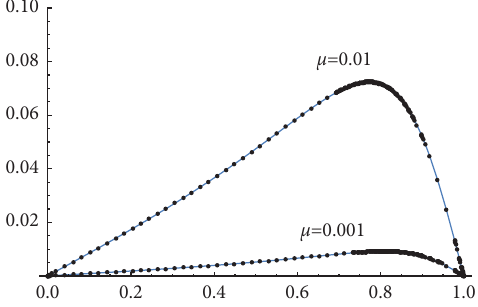
Figure 8: The approximate solution (dotted) with the exact so- lution (solid) for two different values of μ and � 1 , and a � 1 . 2 for Example 0 ≤ x ≤ 1 , T 0